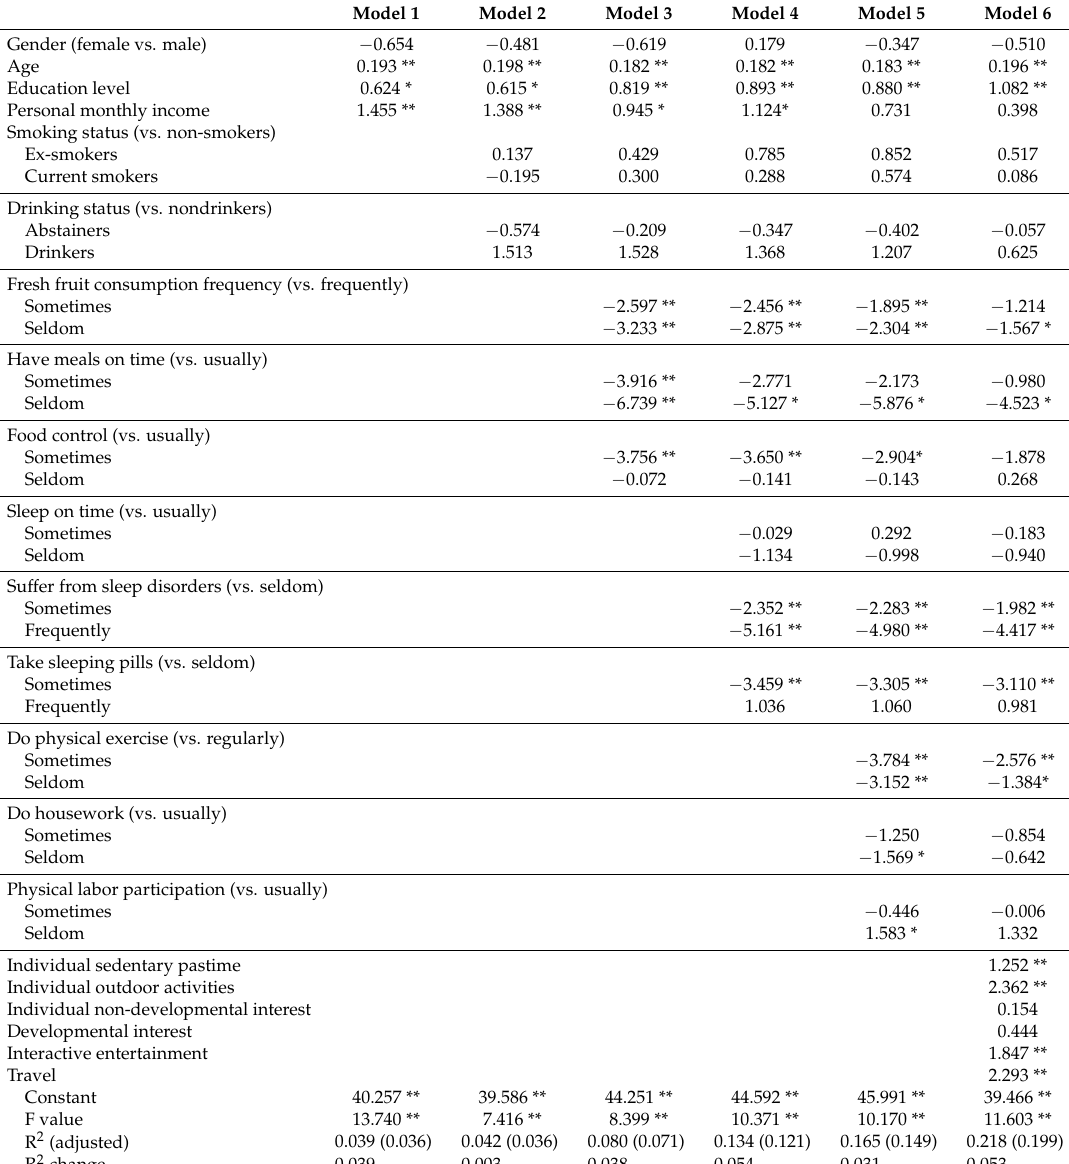
Table 4. Hierarchical linear regression models on the mental component summary score of the